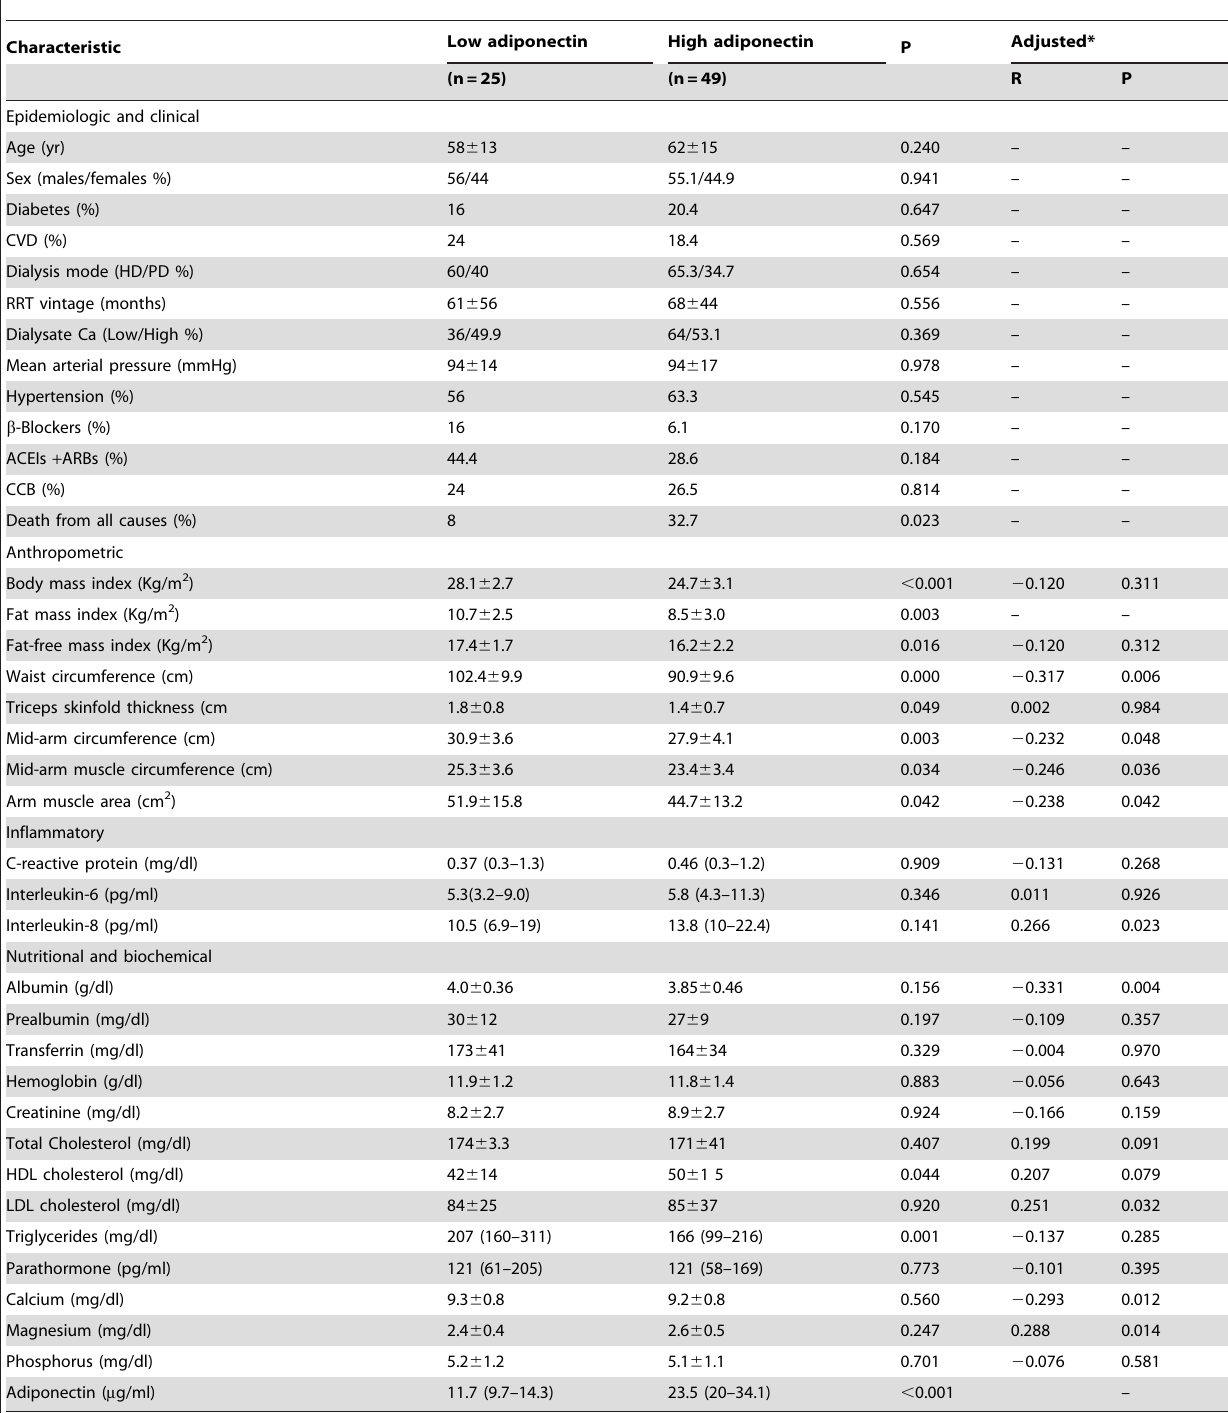
Table 1. Characteristics of the patients classified into low- and high- adiponectin levels.